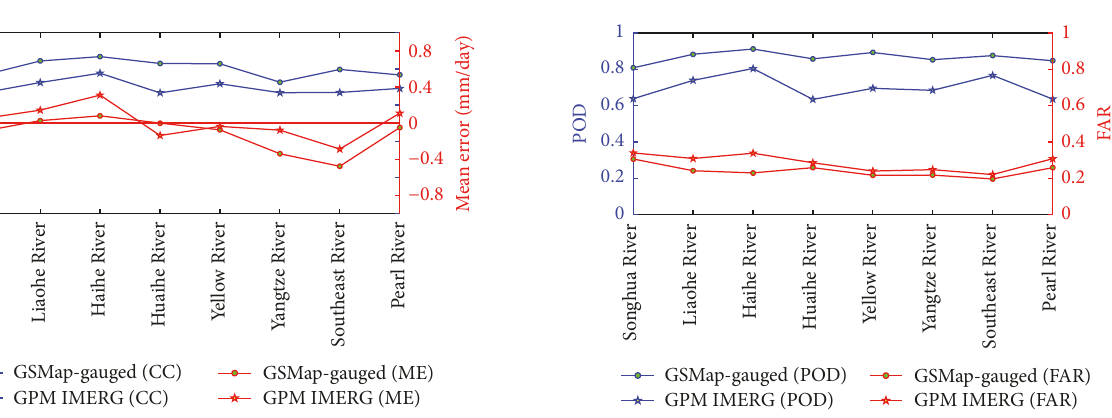
Figure 13: Spatially averaged POD and FAR at the eight main basins over eastern China at the monthly scale from April 2014 to March